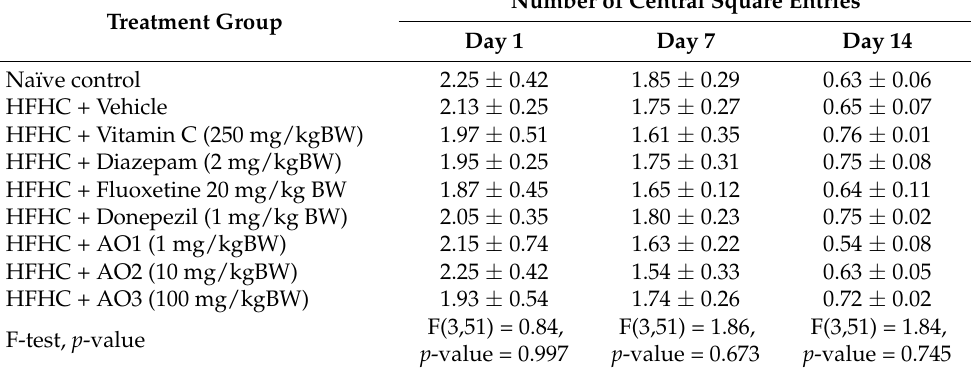
Table 2. Effect of the functional ingredient containing cashew leaf extract and cashew apple pomace- derived dietary fiber (AO) on number of central square entries. Data are presented as mean ± SEM) n = 6/group.